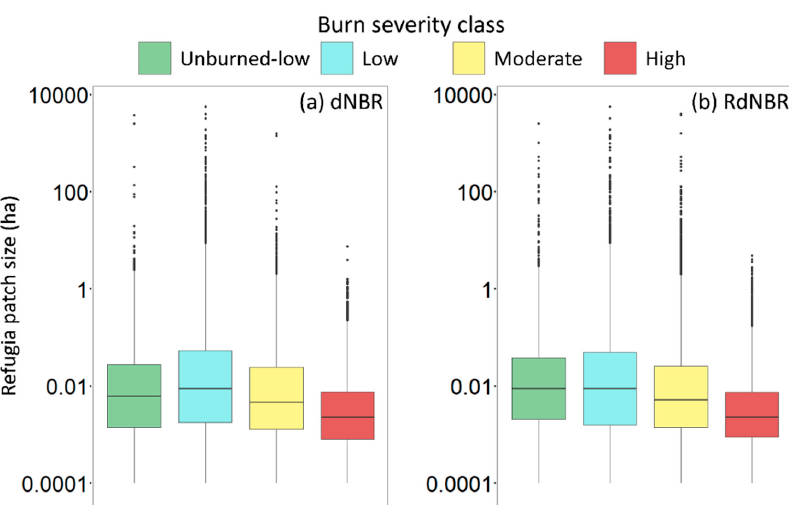
Figure 4. Summary of fire refugia patch sizes partitioned by burn severity for ( a ) Monitoring Trends in Burn Severity (MTBS) di ff erenced normalized burn ratio (dNBR)-based severity classes and ( b ) relative di ff erenced normalized burn ratio (RdNBR)-based severity classes (Miller and Thode 2007). Note: y-axis is log-scaled.